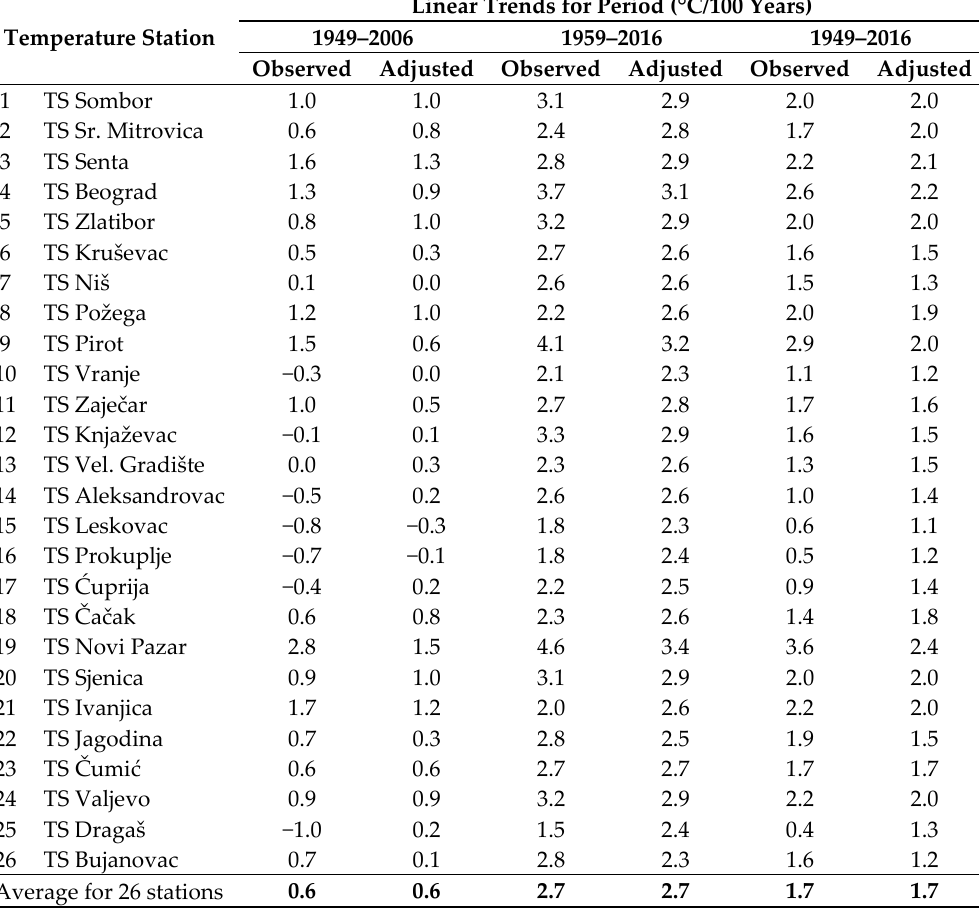
Figure 1. The locations of selected T stations (Figure 1a) and spatial T trend distribution (°C/100 years) for periods 1949–2006; 1959–2016 and 1949–2016 (Figure 1b–d). Table 1. Selected T stations with observed and adjusted annual trends for analyzed